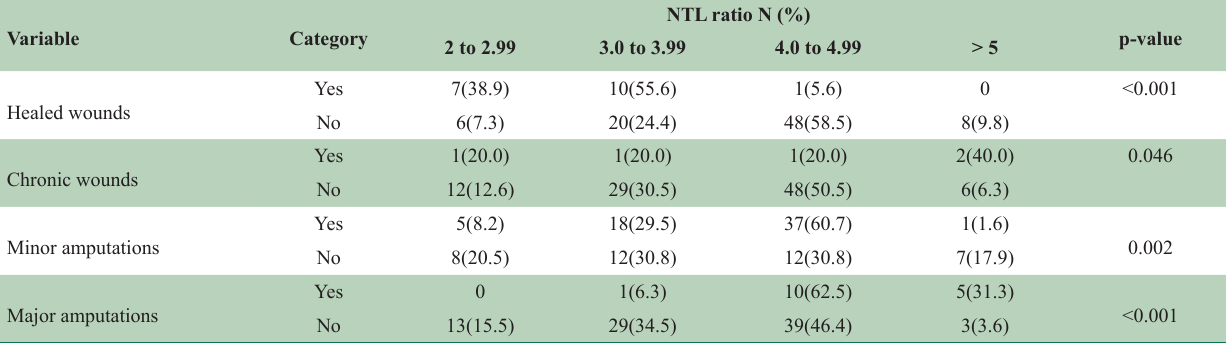
Table-III: Association table among the NTL ratio and DFS by applying Chi Square